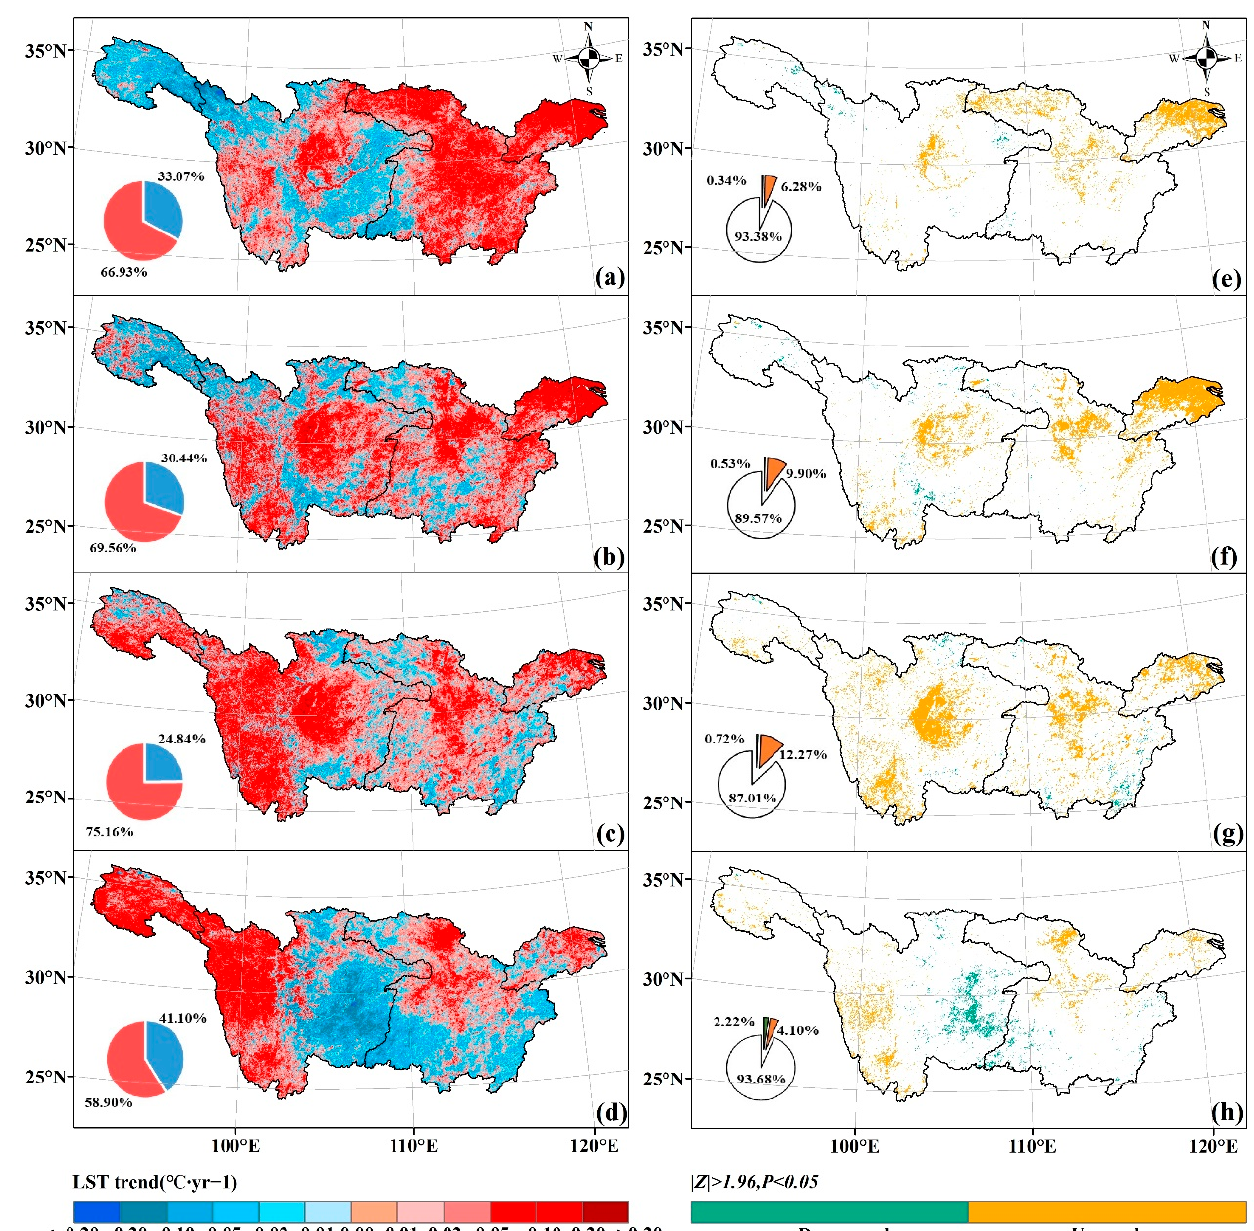
Figure 5. Trend variation and its significance of LST from 2003 to 2020 in winter ( a ) and ( e ); spring ( b ) and ( f ); summer ( c ) and ( g ); and autumn ( d ) and ( h ). The inset pie charts show the percentage of area with an uptrend and downtrend, respectively ( a − d ), and the percentage of area with a significant uptrend, significant downtrend and insignificant change, respectively ( e − h ).